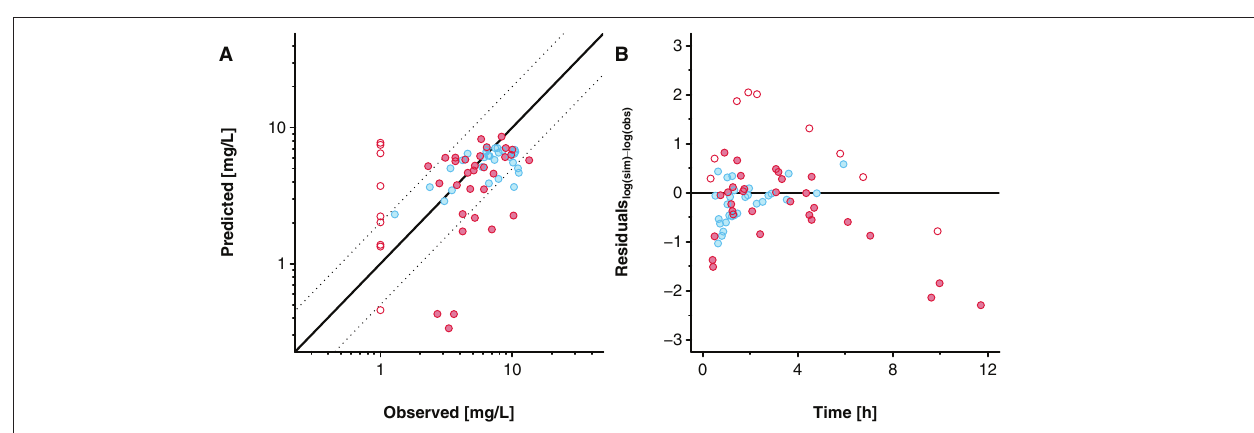
FIGURE 7 | Goodness-of-fit plot (A) and residuals versus time plot (B) for the predicted acetaminophen concentrations in the umbilical vein . Blue and red circles indicate clinical data reported by Nitsche et al. (17) and Mehraban et al. (18). Data from Mehraban et al. (18) below the lower limit of quantification (LLOQ) are included as LLOQ/2 and empty circles in the figure. In (A) , the solid line indicates the line of identity and the dashed lines limit the 2-fold error range. In (B) , the solid line indicates the level where the residuals are zero.